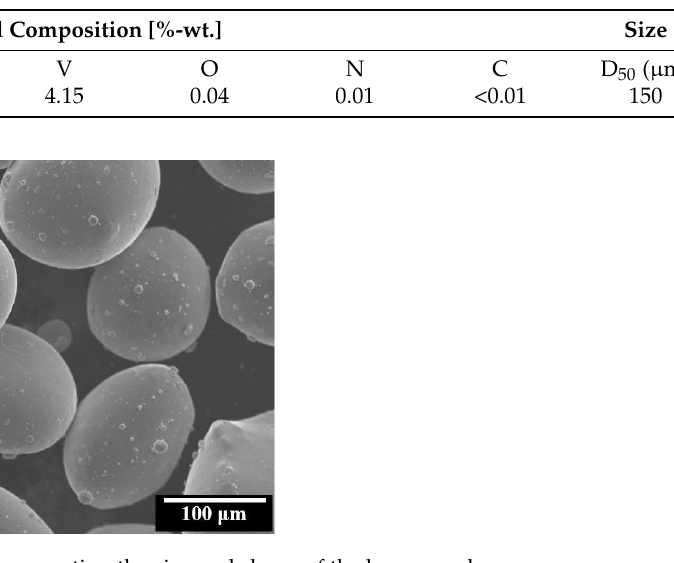
Figure 1. SEM micrograph presenting the size and shape of the base powder. Sanitary grade 316L stainless steel (CFF Stainless Steels Inc., Montreal, QC,